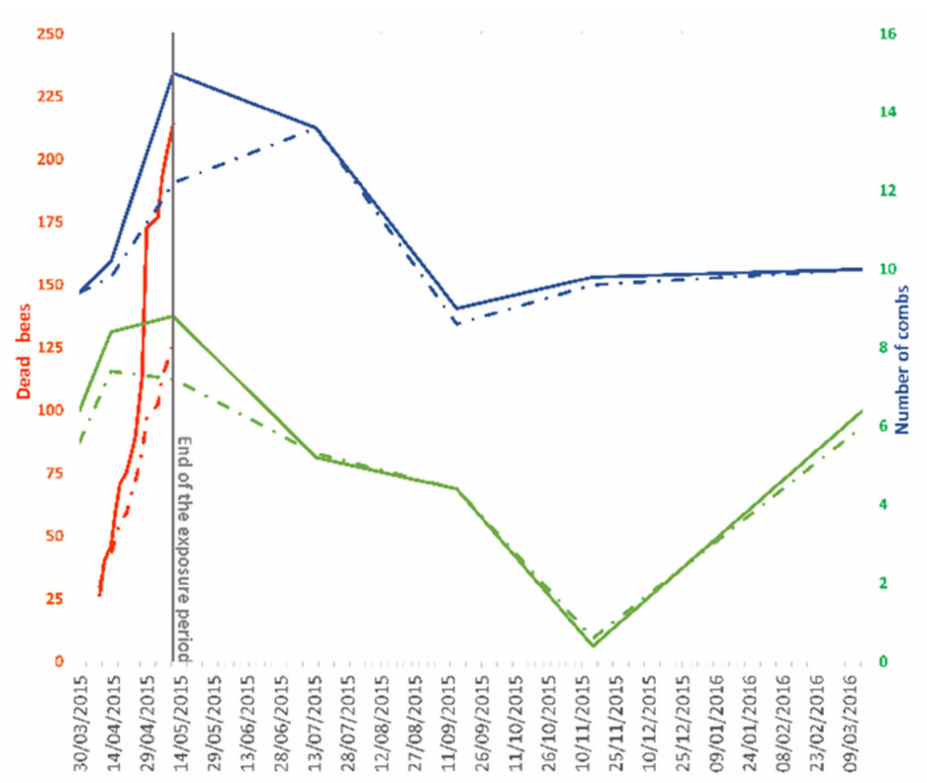
Figure 3. Colony strength parameters throughout the study in control and treatment (TMX) apiaries: mean accumulated dead bees at the entrance of the colonies ( — • — control; — TMX) and mean